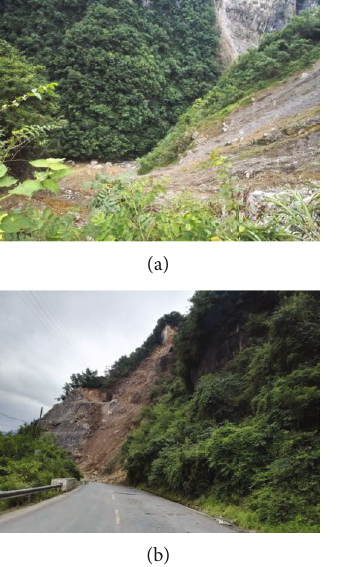
Figure 10: Distribution of colluvium block stones at river bottom (a) and G318